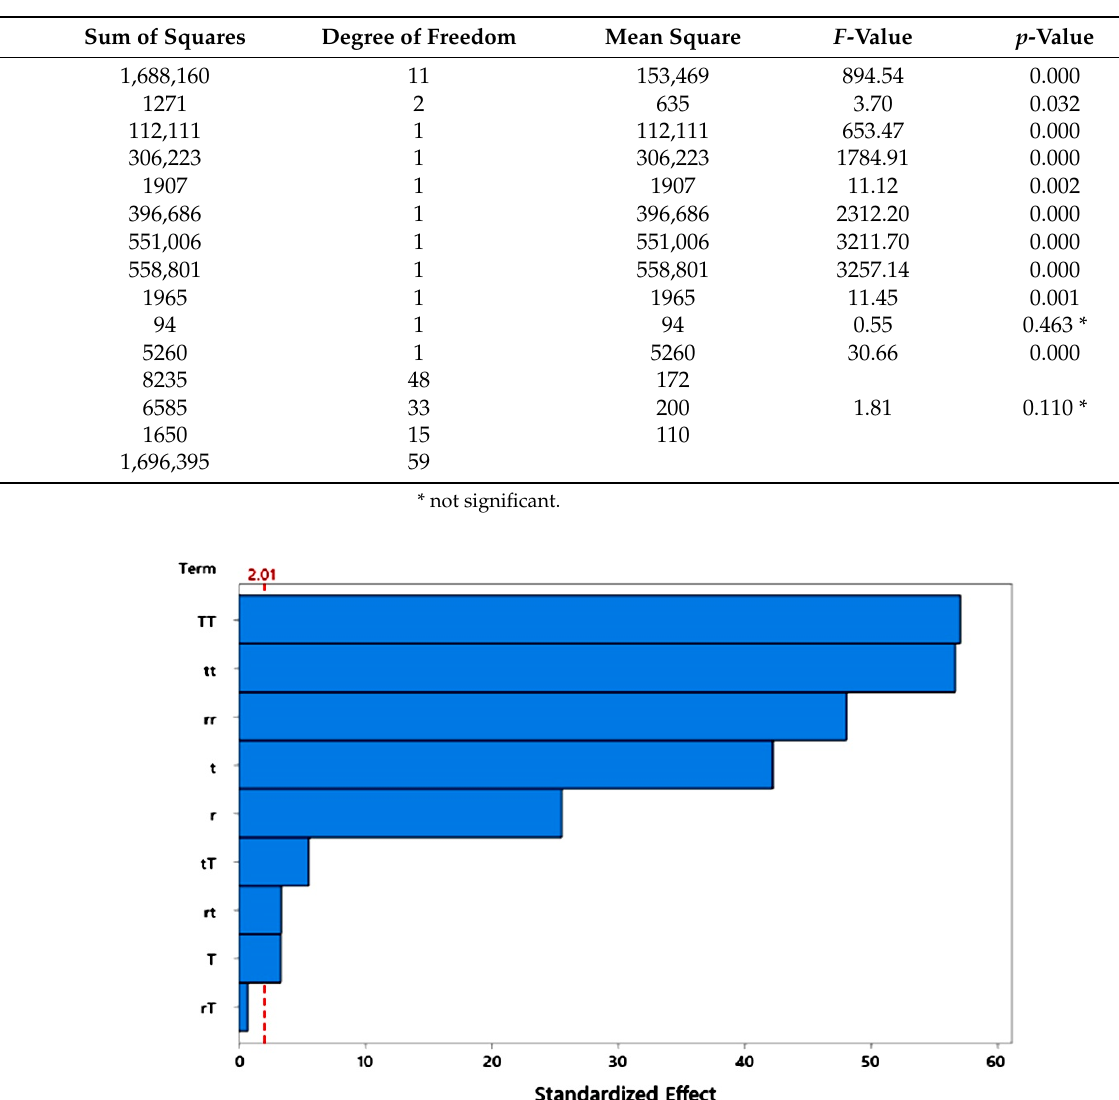
Table 2. Analysis of variance results.